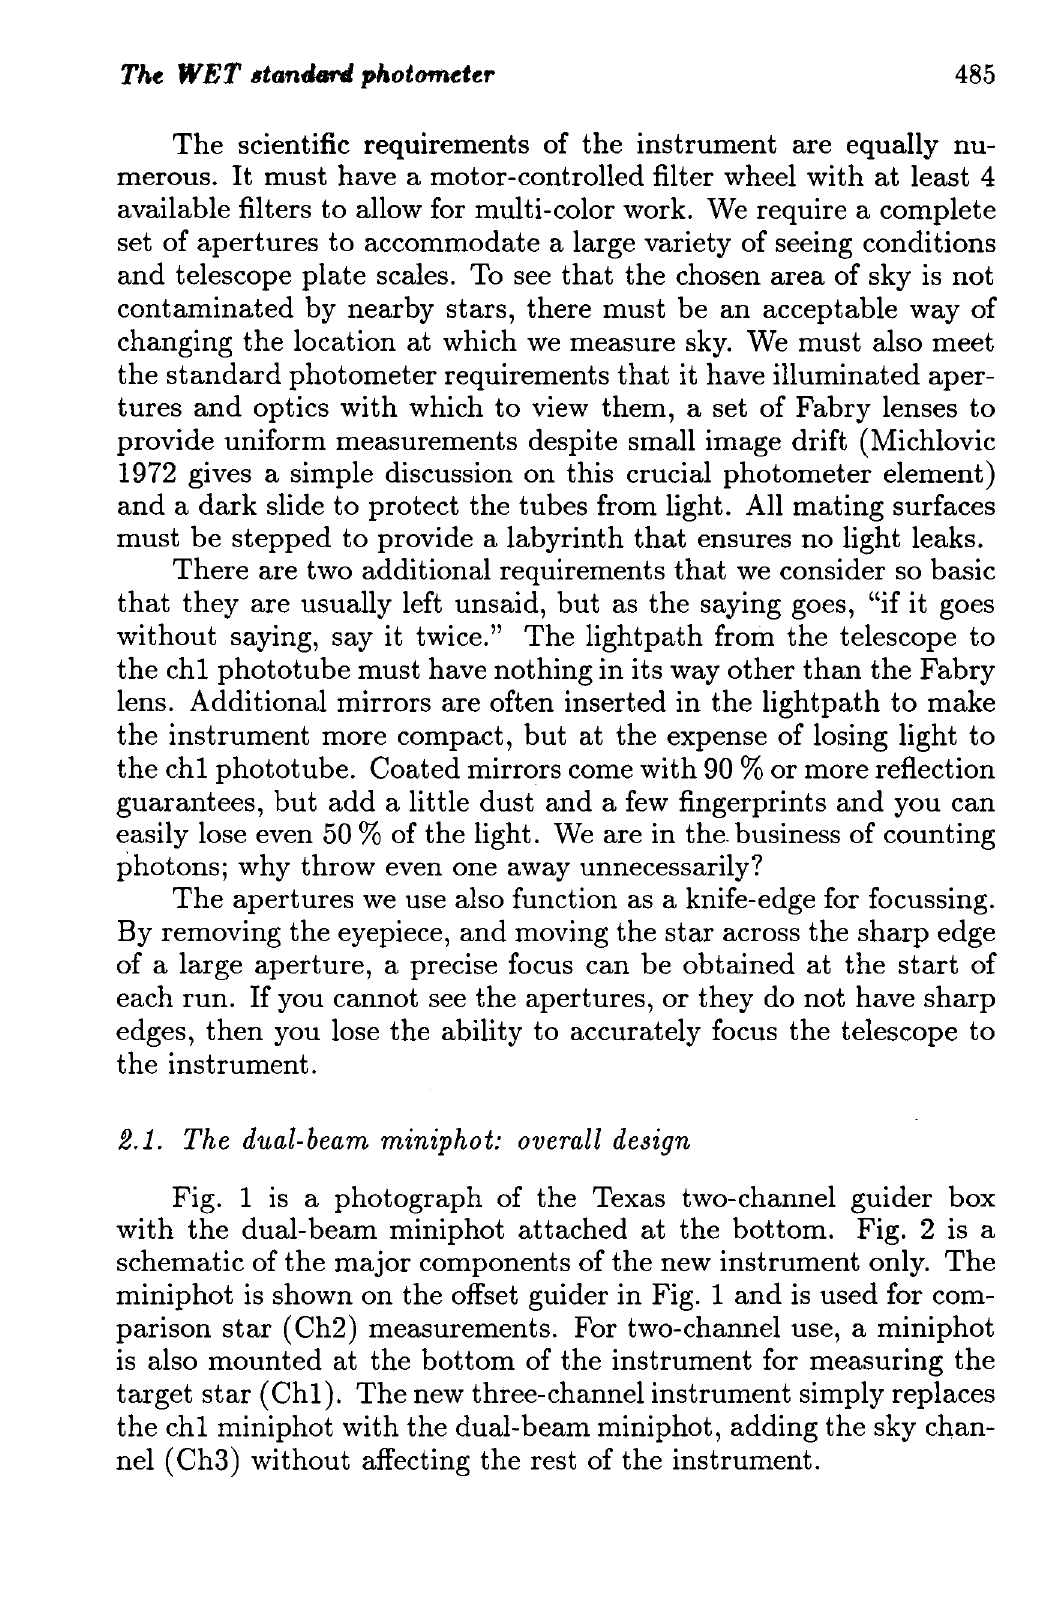
Fig. 1 is a photograph of the Texas two-channel guider box with the dual-beam miniphot attached at the